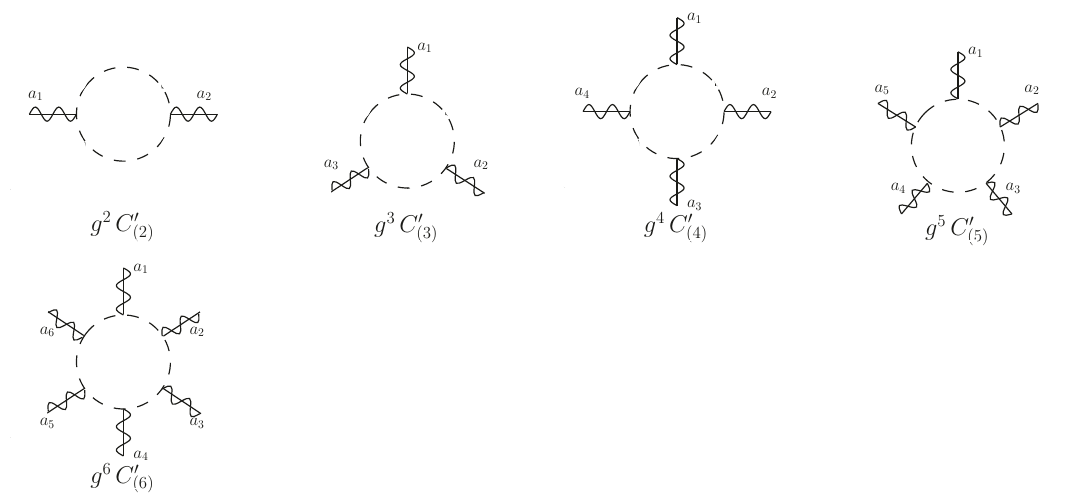
Figure 2 . Building blocks up to g 6 order. The dashed lines stand for hypermultiplet loops, the wavy/solid lines stand for (cid:12)elds belonging to color